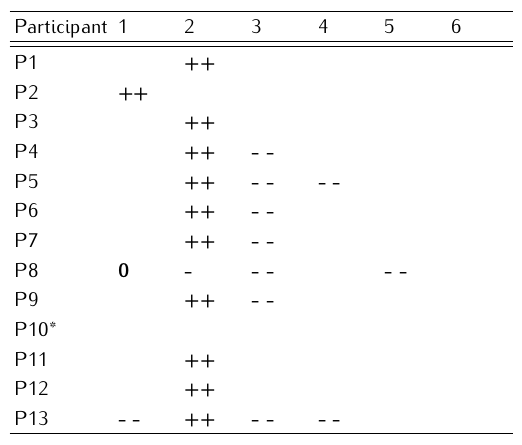
Table 3. The spatial formations that occurred in situation S2. The symbols in- dicate how much time was spent in each formation: - -. 0-10%, -. 11-40%, 0. 41-59%, +. 60-89%, ++. 90-100%. 1. Vis-a-vis, 2. L- shape, 3. Side-by-side, 4. Look-away, 5. Ahead and 6. Follow. The participant marked with an * experienced a different scenario in S2 not captured by C2.